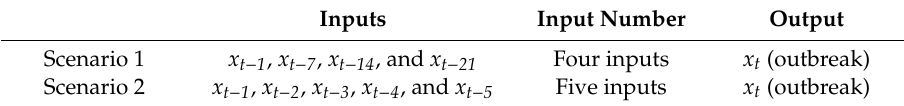
Table 2. Input and output variables for training ML methods by time-series